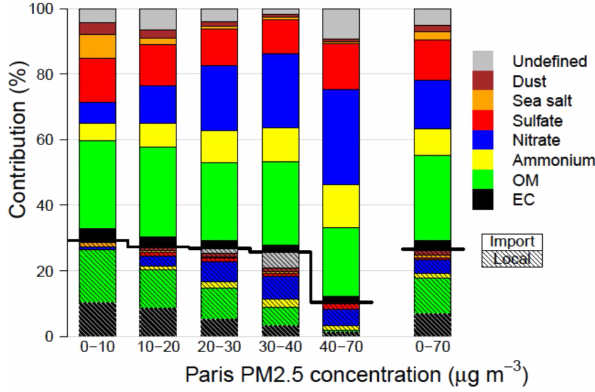
Figure 3. Local (hatched) and imported contributions to PM 2 . 5 in Paris (PARTICULES urban background site) for the period Septem- ber 2009 to September 2010, for different PM 2 . 5 levels. An uncer- tainty range of ± 5% (absolute value) is estimated for the local and imported PM 2 . 5